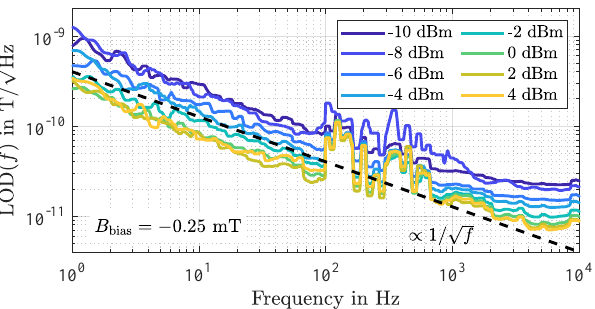
Figure 14. Measured equivalent magnetic noise floors for various input power levels P 0 at an ambient magnetic bias flux density of B bias = − 0.25mT (after a negative magnetic saturation). The 1/ dependency confirms Equation (24), i.e., magnetic hysteresis losses dominate under these operat- ing